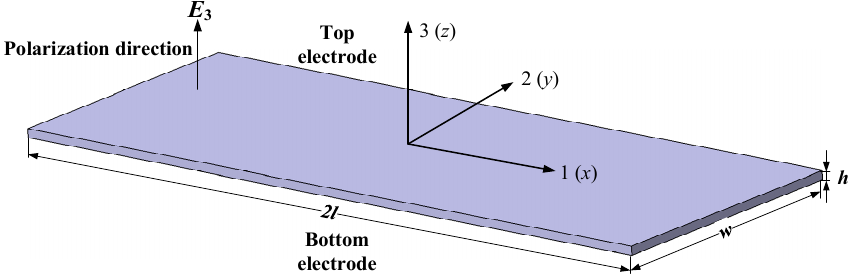
Figure 1. Schematic of a thin-wall 1D piezoelectric sensor.